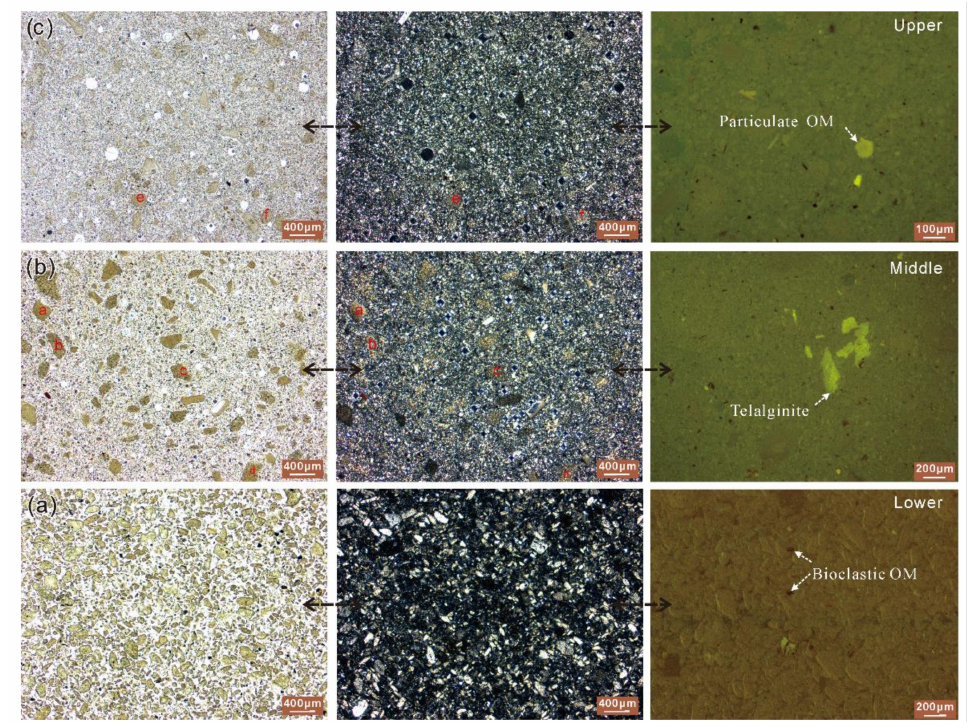
Figure 5. Features of thin section and polished section for lower ( a ), middle ( b ), and upper layers ( c ) in low-mature oil shales (Sample S50), showing photographs of thin sections with plane ( − ) and perpendicular (+) polarized light, and polished sections with fluorescent light.